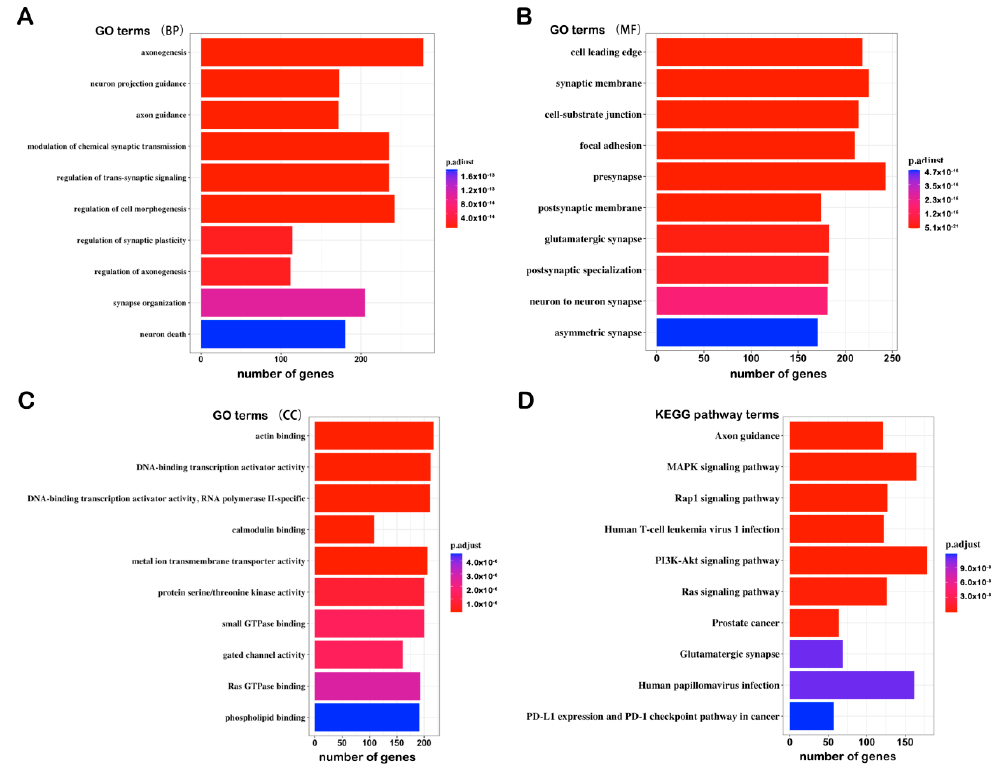
Figure 4. Top 10 GO and KEGG terms of the analysis of the differentially methylated genes (DMGs): ( A ) Biological process; ( B ) molecular function; ( C ) cellular component; ( D ) KEGG pathway.